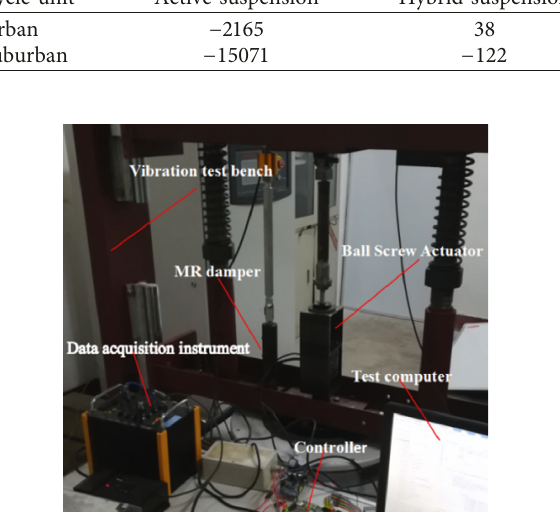
Figure 23: The test system of the hybrid active